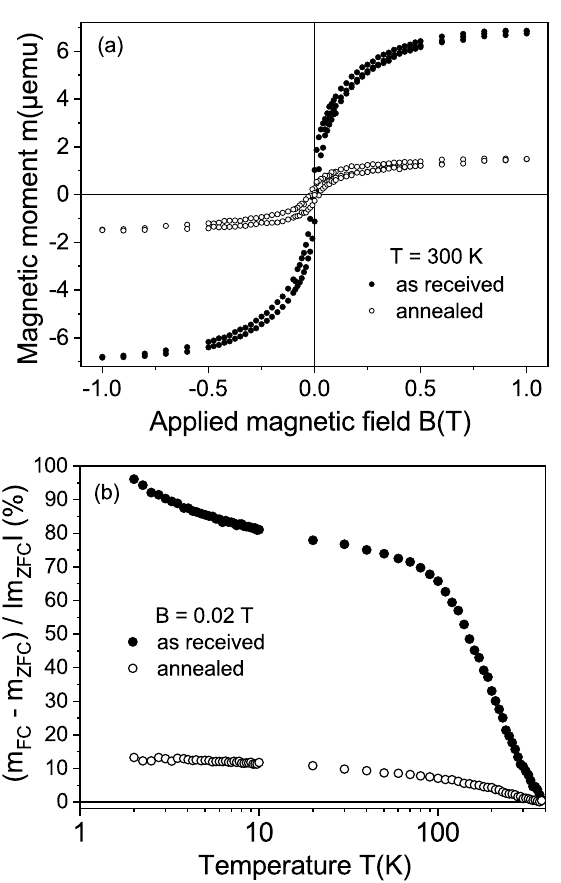
Figure 8. Magnetic properties of sample #1b: ( a ) Field hysteresis loops at 300 K in the as-received state and after the high-temperature annealing. ( b ) Temperature dependence of the relative difference 100 [ m F C ( T ) − m Z FC ( T )] / | m Z FC ( T ) | at a field of 0.02 T, before and after